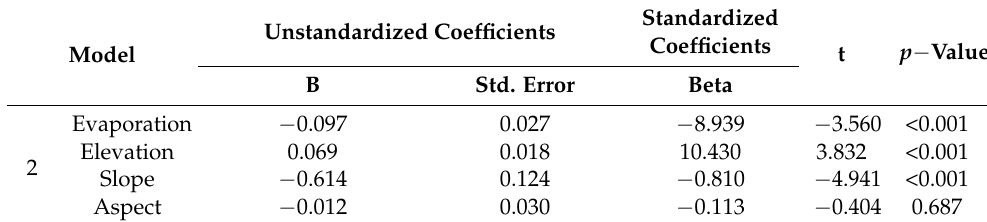
Table 3. Second run of BMLR.